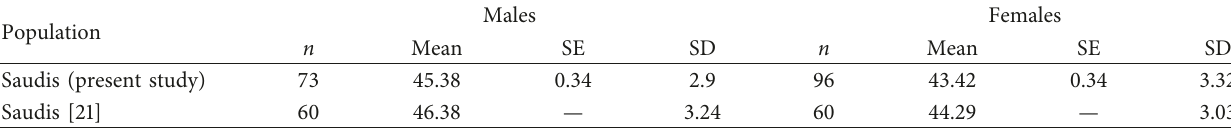
Table 7: Comparison of intermolar (upper first molar central fossa to central fossa) widths between Saudis (different studies). Population Saudis (present study)